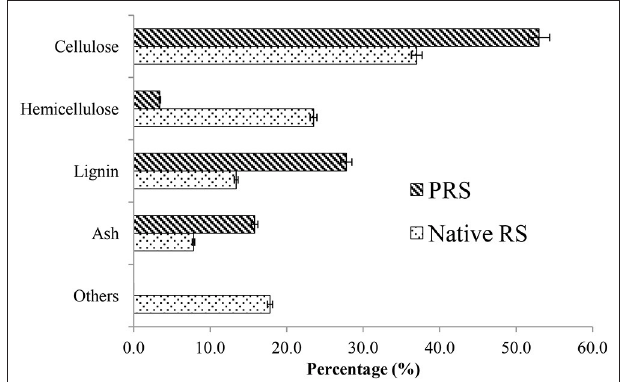
FIGURE 1 | Composition of native- and acid-pretreated rice straw as determined by NREL LAP.